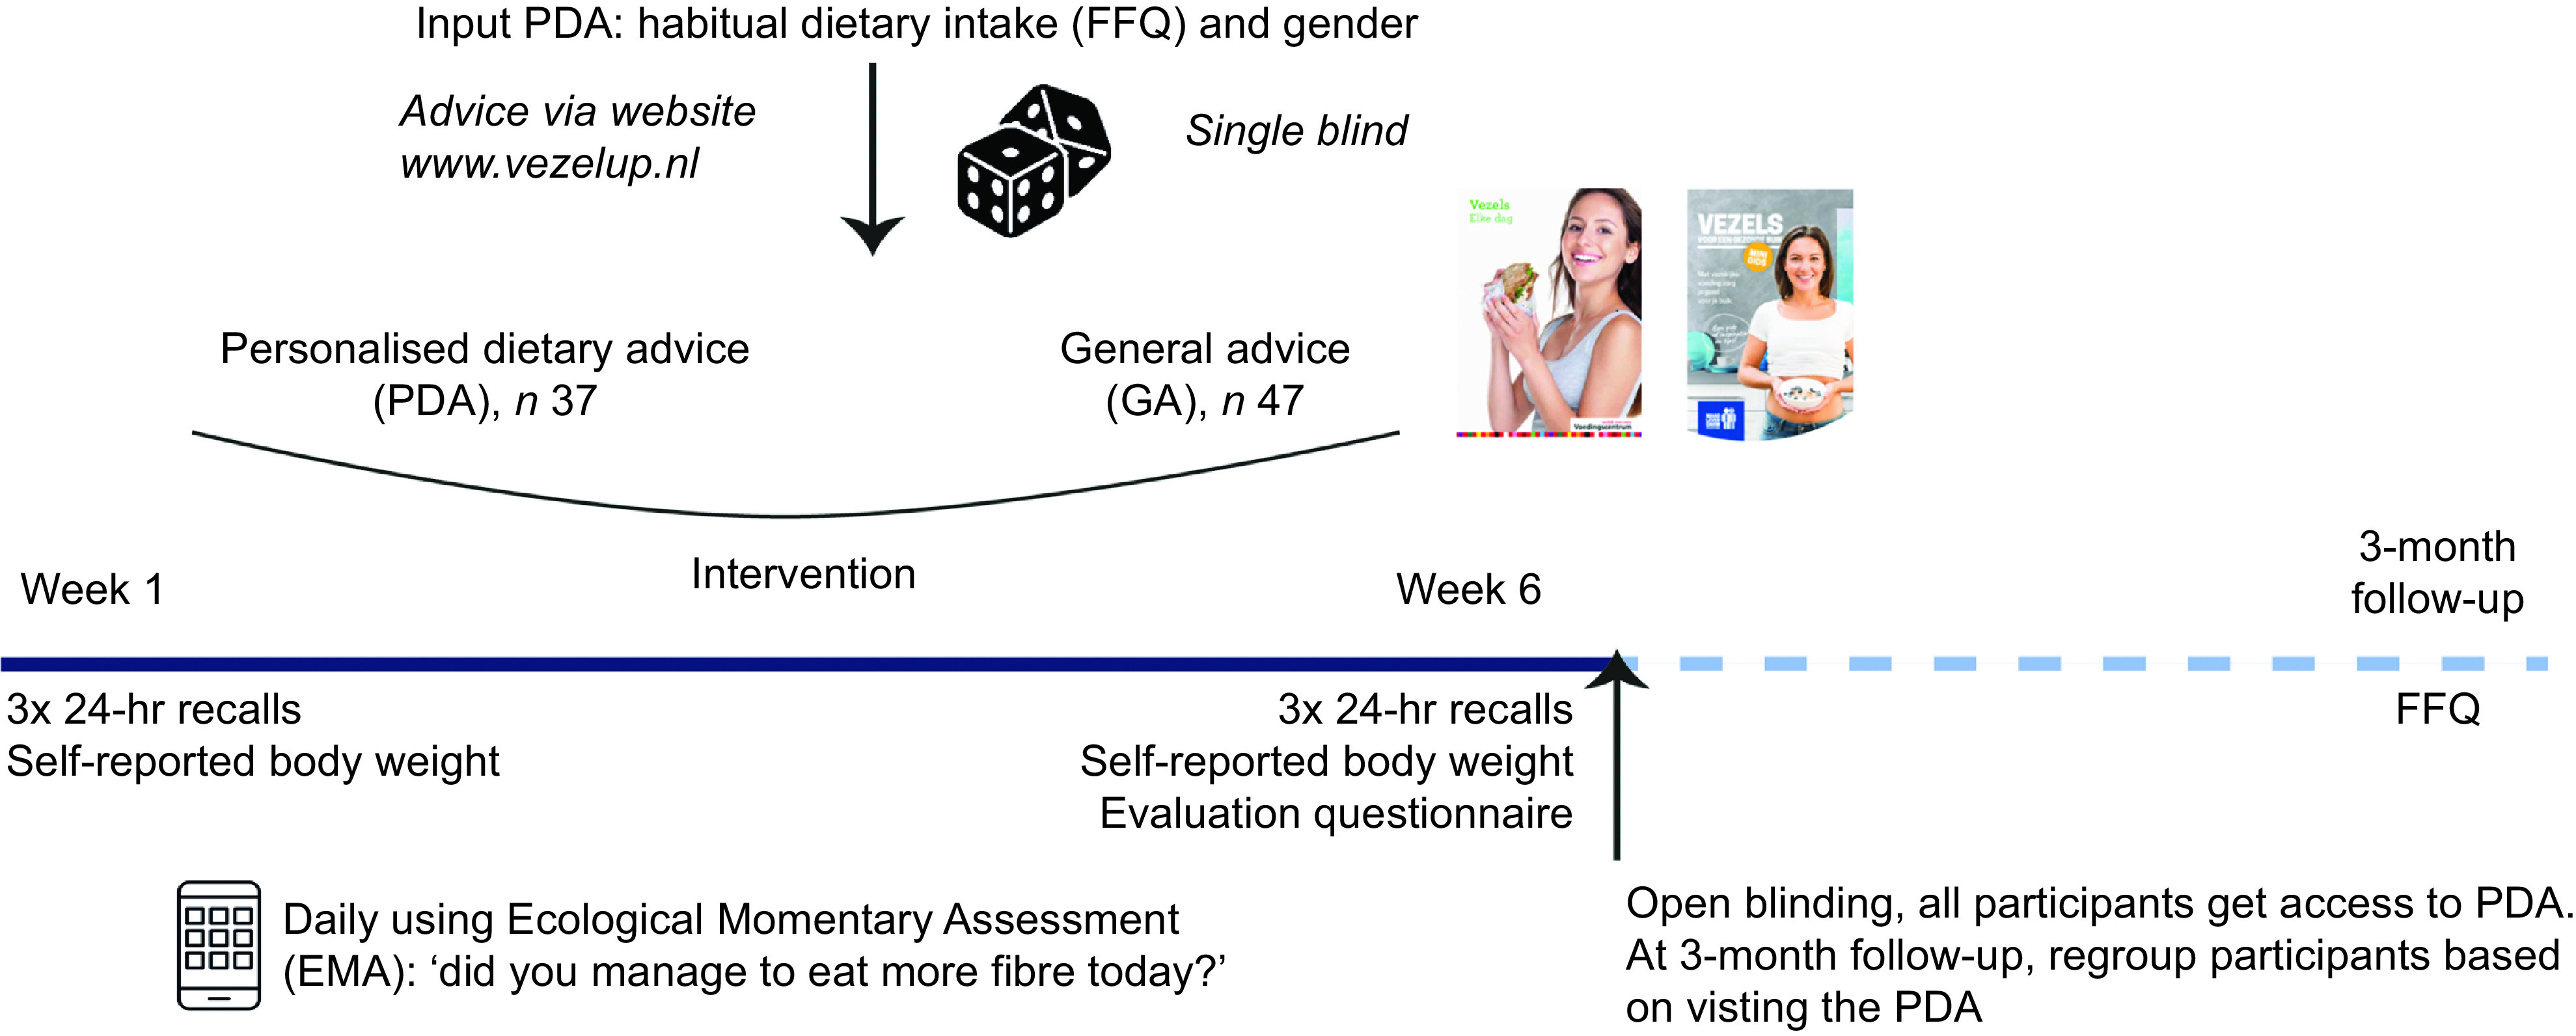
Overview of the study design. Questionnaires are performed online or via mobile application. General advice consisted of two flyers of the Netherlands Nutrition Center and the Dutch Digestive Foundation, and a website containing general information. The intervention group also received this information and their personal advice